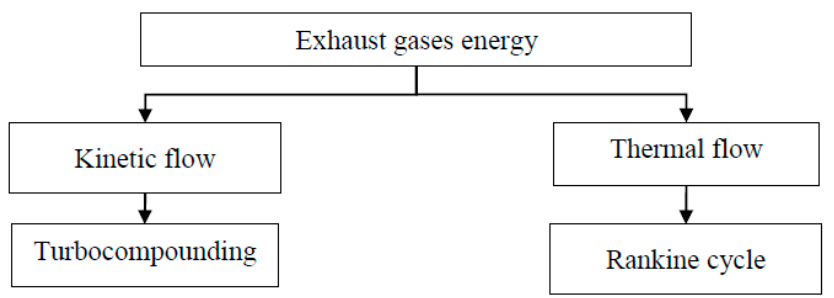
Figure 2. The principle methods for exhaust gas recovery. Source: developed by authors.